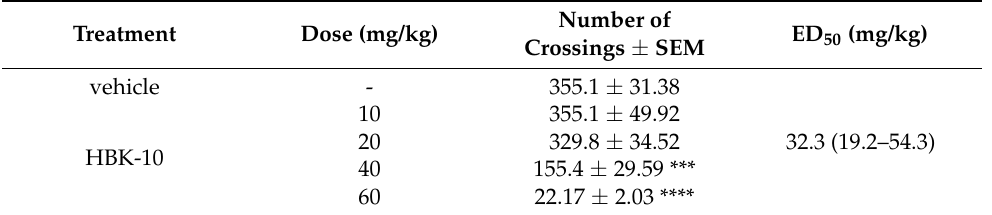
Figure 7. The effect of HBK-10 and fluoxetine on the immobility in the forced swim test after a chronic administration in corticosterone-treated mice. After 3 weeks of either corticosterone or vehicle injections sc , mice were administered ip with HBK-10 (0.625 or 1.25 mg/kg), fluoxetine (15 mg/kg), or vehicle (1% Tween) for next 3 weeks, 30 min before the corticosterone or vehicle injections. 24 h after the last compounds’ administration, the forced swim test was performed. The results are presented as box plots showing the following data: mean (‘+’), median (horizontal line), upper and lower quartile (the width of the box shows interquartile range), upper and lower extreme (whiskers). Statistical analysis: Shapiro–Wilk test for normality, Brown–Forsythe test for homogeneity of variance, and one-way ANOVA (Newman–Keuls post hoc); ** p < 0.01, **** p < 0.0001; n = 8 mice per group. Table 7. The effect of HBK-10 on locomotor activity in